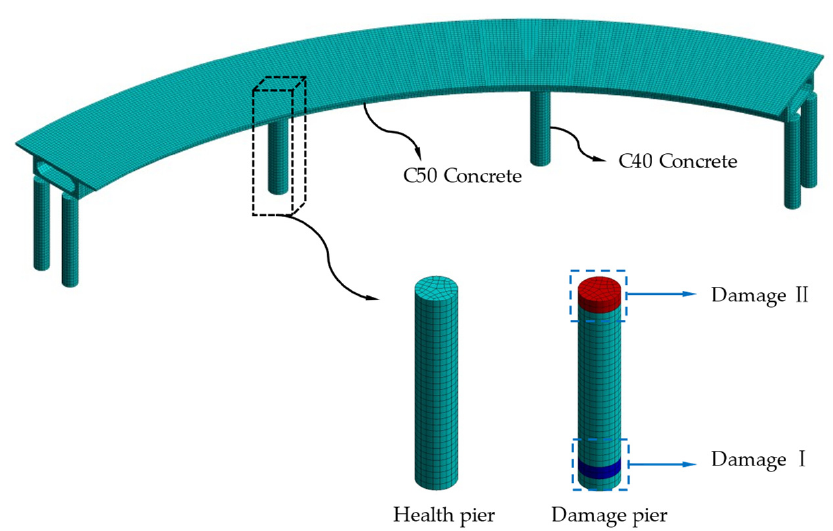
Figure 2. Geometric dimensions of the CCRFB: ( a ) plane graph; ( b ) elevation graph; ( c ) main girder cross section.